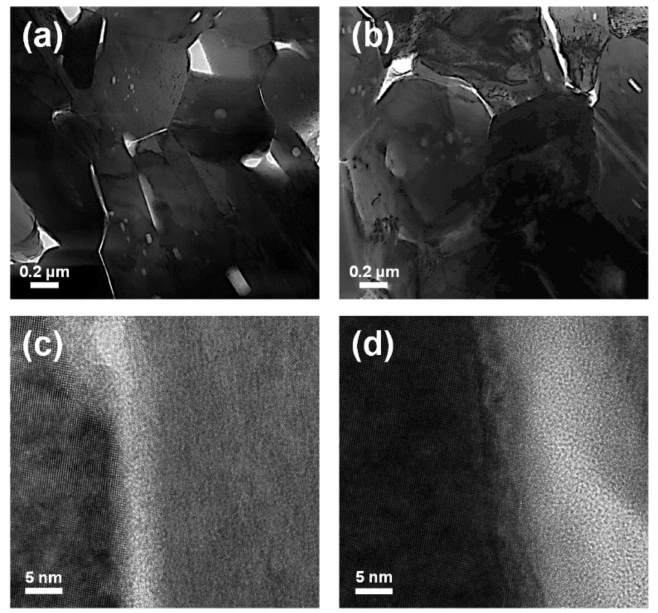
Figure 4. TEM images of the Bi 2 Te 3 –polypyrrole specimens sintered at 350 ( a , c ) and 400 ◦ C ( b , d ) at different